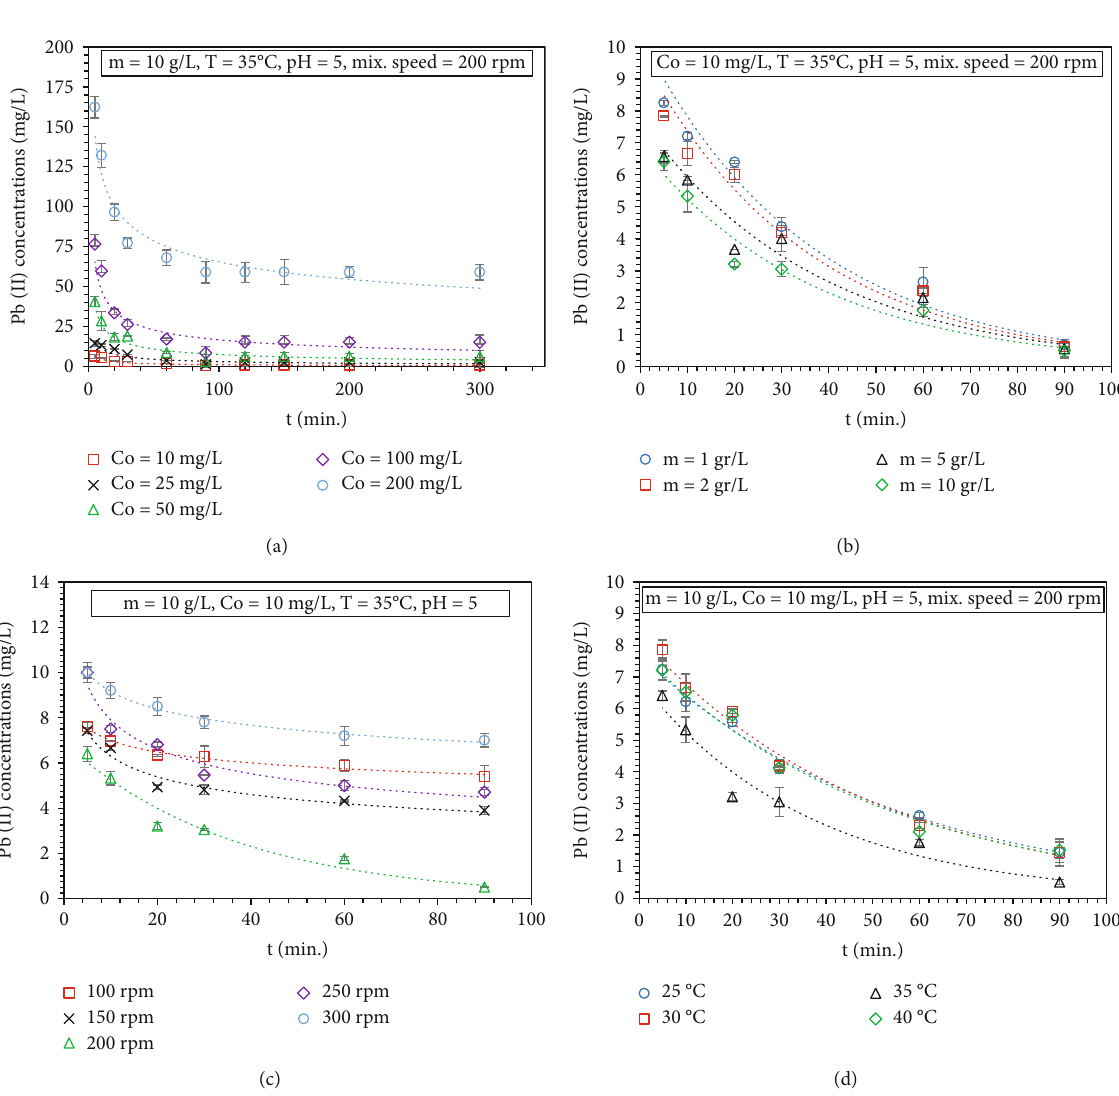
Figure 2: Pb (II) concentration changes over time at di ff erent conditions for MBS. ± SD shown by error